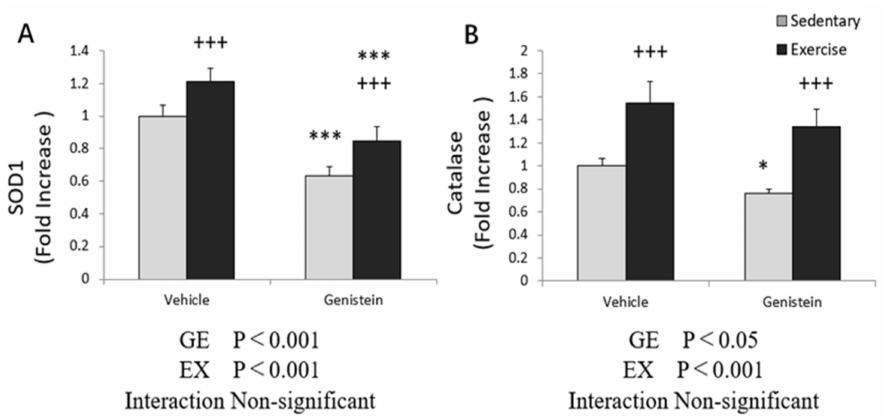
Figure 9. ( A ) SOD1 mRNA (Con, n = 7; GE, n = 7; Ex, n = 7; GE + EX, n = 7); ( B ) CAT mRNA (Con, n = 8; GE, n = 7; Ex, n = 6; GE + EX, n = 7), vehicle: non-supplemented groups (only administrated with 0.5% CMC-Na solution); GE: GE-supplemented groups. +++ p < 0.001, the main effect of exercise. * p < 0.05, *** p < 0.001 main effect for GE treatment. Values are means ± SE.